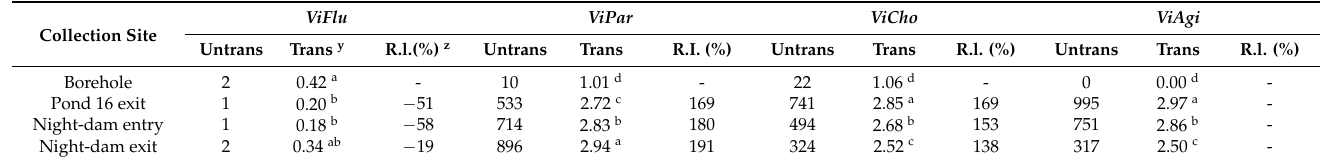
Figure 3. Log-transformed mean counts of Salmonella spp., Shigella spp., Escherichia coli , and fecal coliform in treated wastewater relative to that from borehole water used for irrigation of various crops. Table 2. Log-transformed mean counts of Vibrio fluvaris ( ViFlu) , Vibrio parahaemolytica (ViFlu) , Vibrio cholera (ViCho) , and Vibrio aginolytica (ViAgi) as affected by collection site along the wastewater treatment pathway from Pond 16 exit to night-dam exit relative to those in the borehole